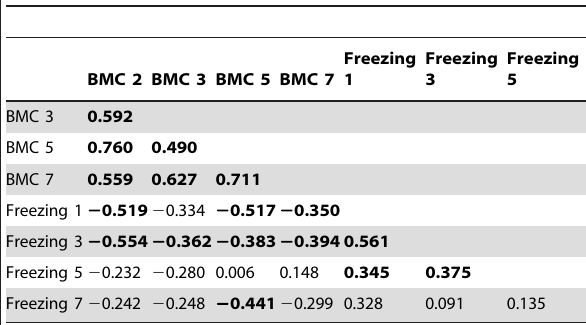
Table 4. Correlation coefficients (R 2 ) between freezing time and total body BMC based on correlation